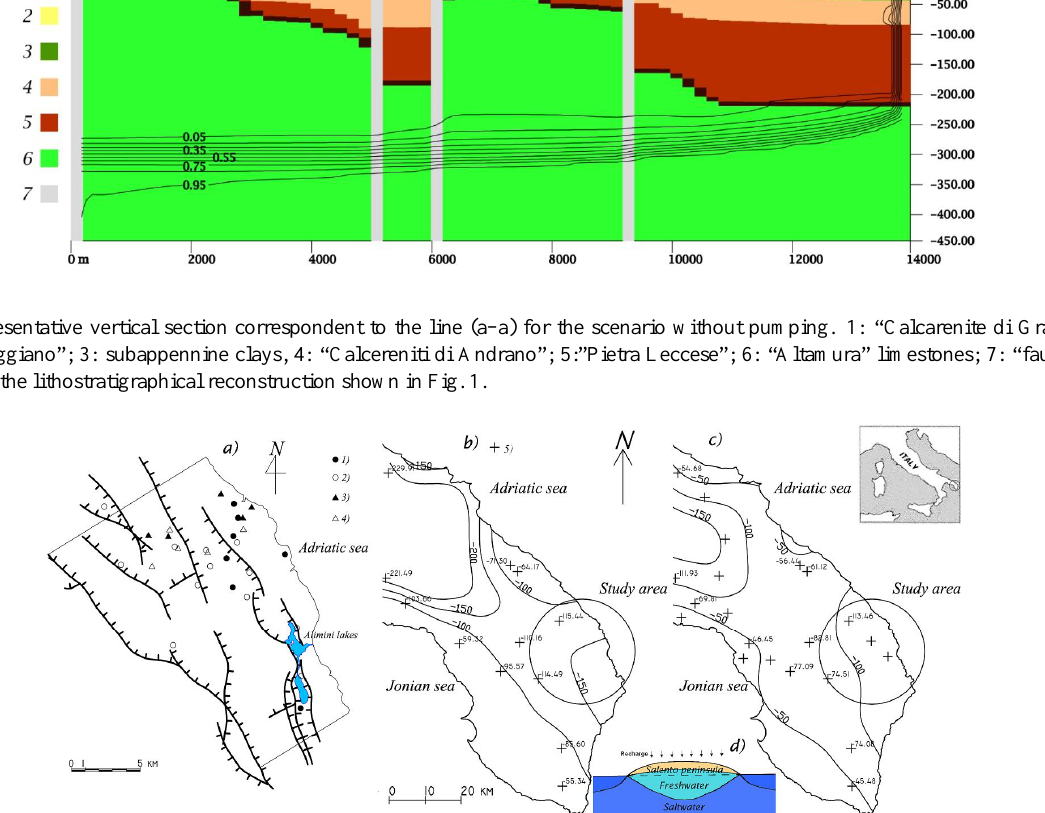
Figure 8: Variable density flow simulation without anthropogenic stresses. The legend label shows the